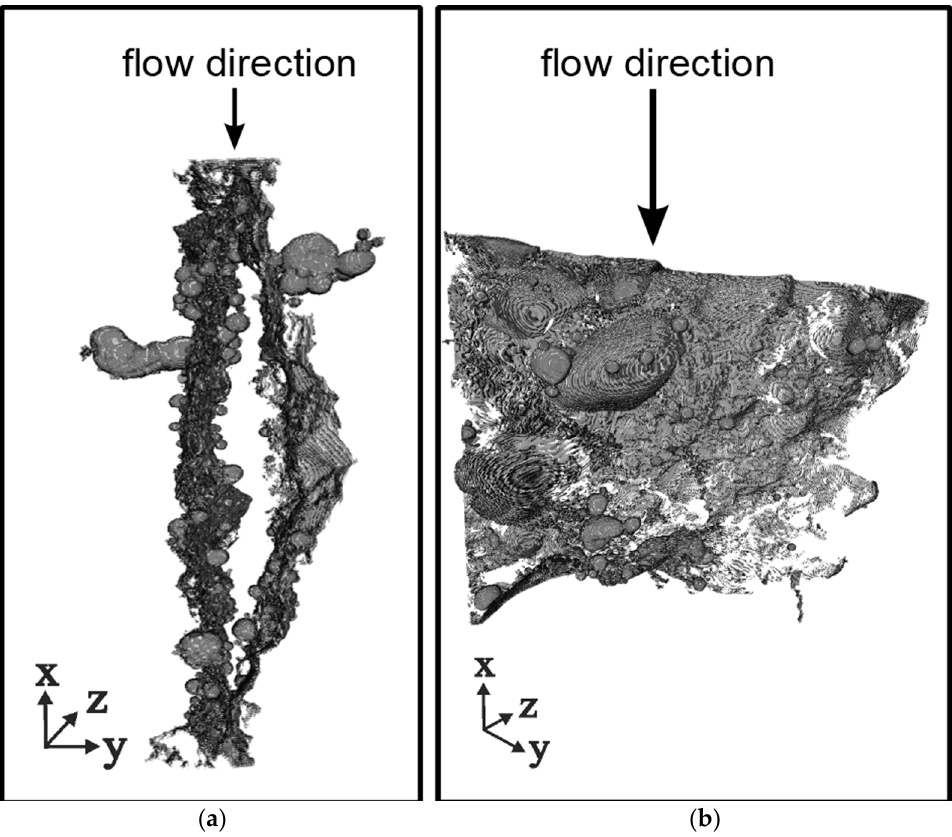
Figure 5. 3-dimensional crack geometry processed with a Matlab script (voxel edge length: 58 µm) ( a ) Local branching into two cracks, ( b ) Areas with discontinuities.